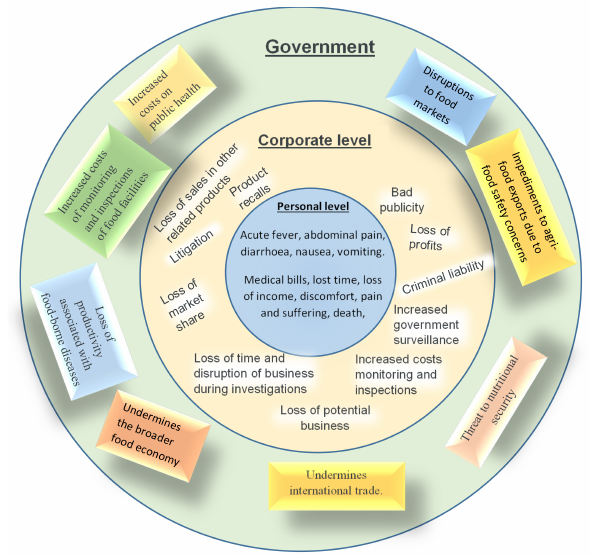
Figure 1. Effects of Salmonella spp. pandemics at personal, company and government level. Approx- imate magnitude of the monetary value of costs increase from the centre